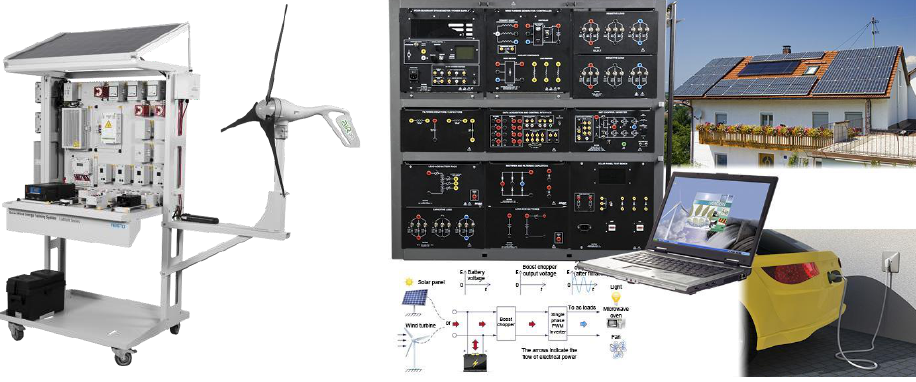
Figure 1. LabVolt Solar House similar to the University of North Texas (UNT) zero energy house model is a good maintenance house example for the energy production and storage farm